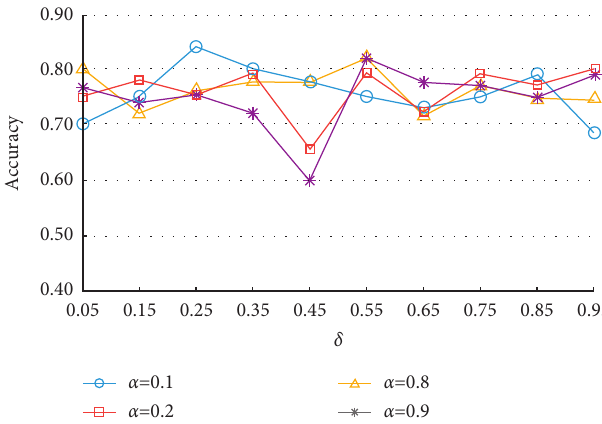
Figure 6: Average accuracies of ECHDNRS on Arabidopsis -TEV dataset. Table 3: Runtime on three datasets.